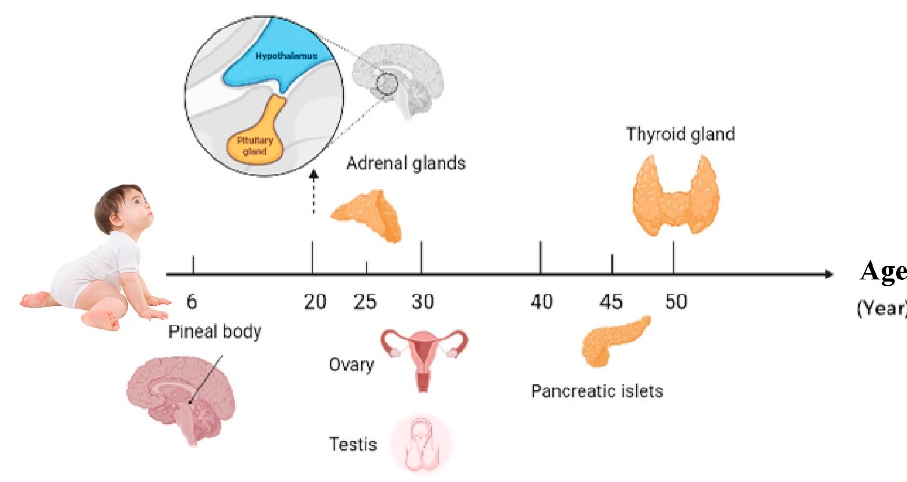
Figure 4. Endocrine glands aging sequence.